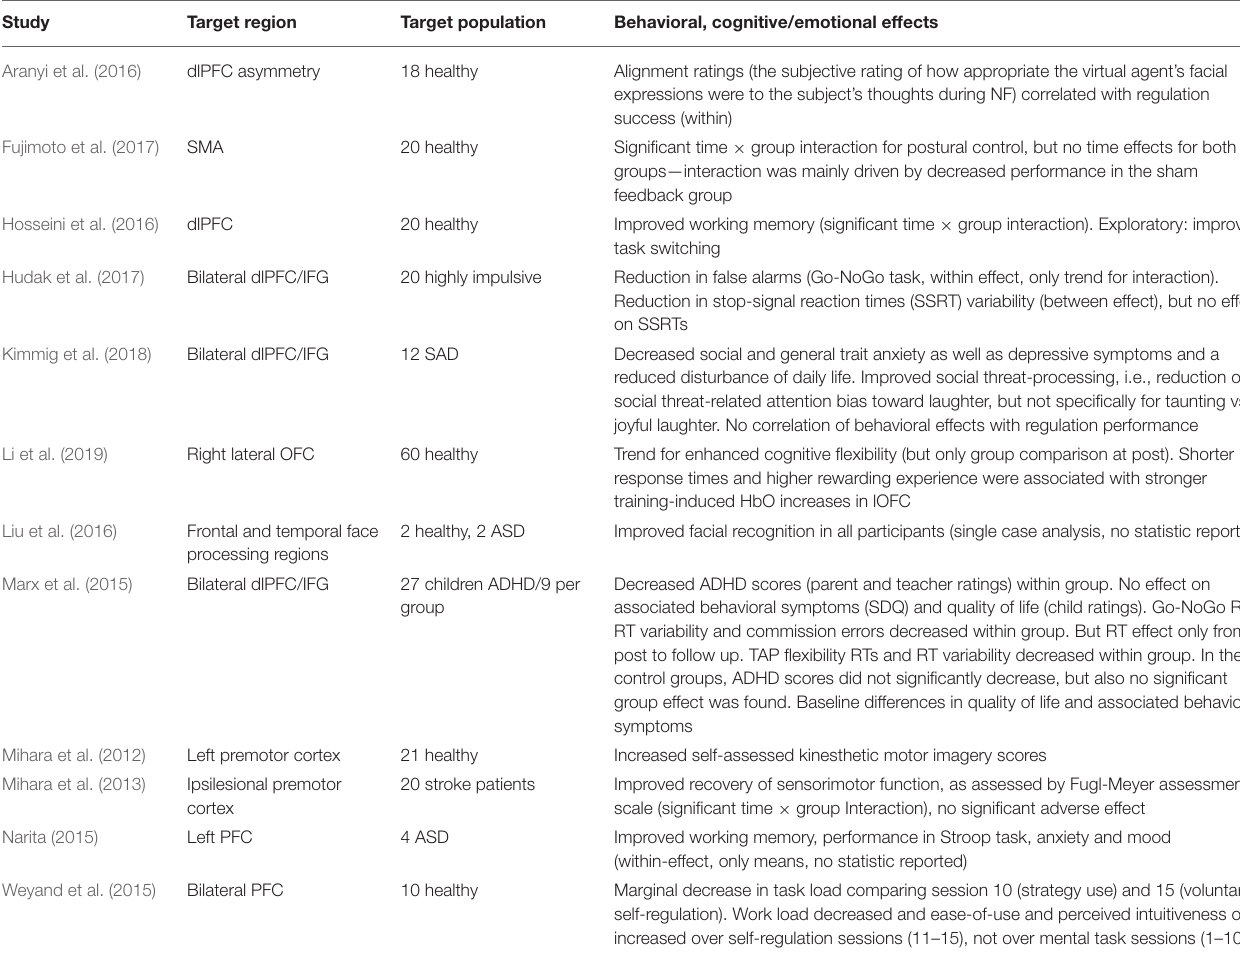
TABLE 7 | Behavioral effects of